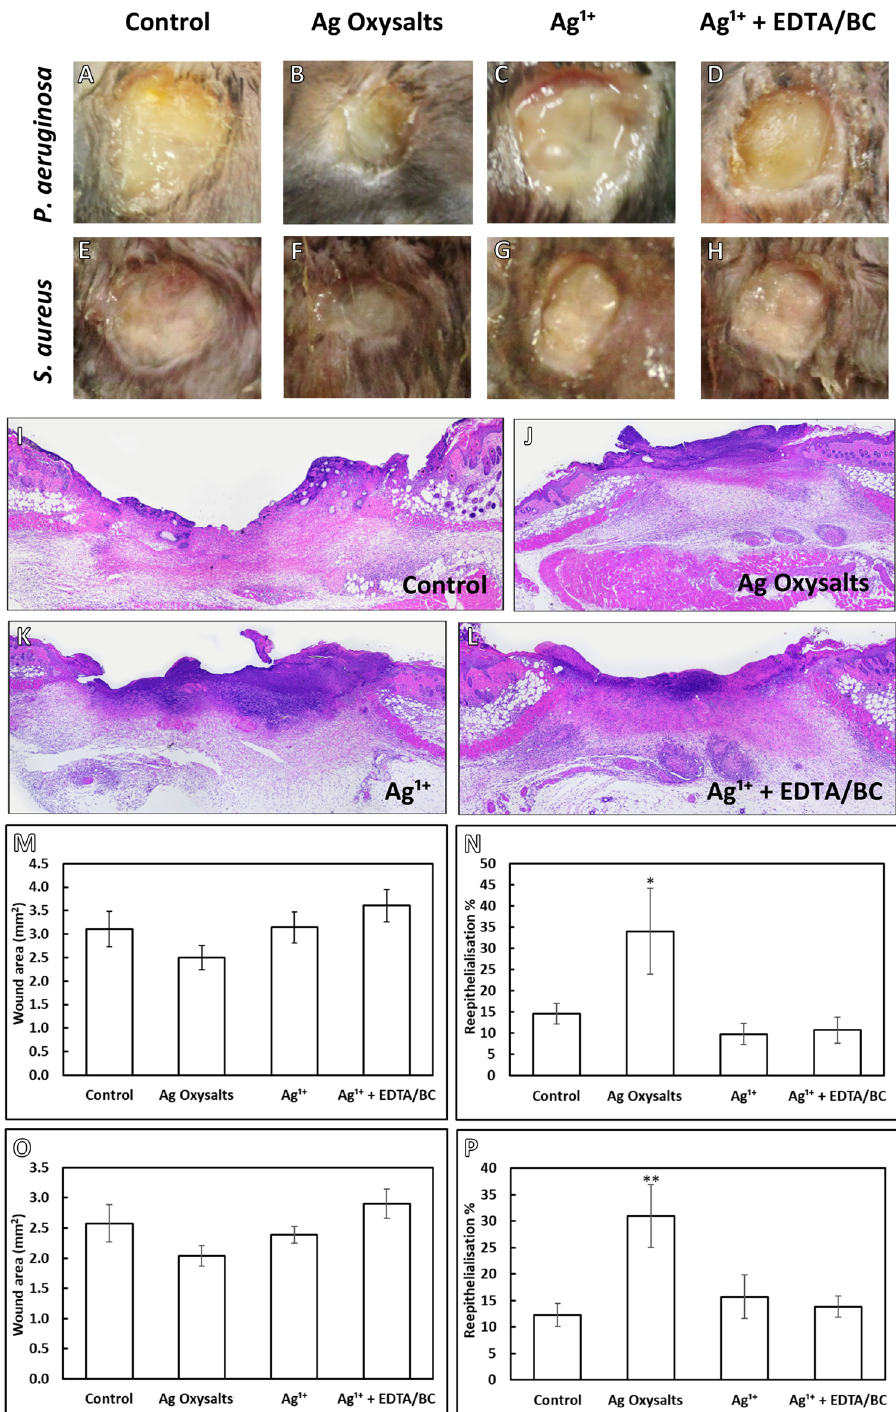
Figure 3. Effects of silver dressings on wound area and re-epithelialisation in biofilm infected wounds. ( A to H ) representative macroscopic images of murine wounds infected with P. aeruginosa ( A – D ) and S. aureus ( E – H ) biofilms following three days treatment with a non-antibacterial control dressing, Ag Oxysalts dressing, Ag 1+ dressing and Ag 1+ + EDTA/BC dressing. ( I – L ) Representative P. aeruginosa infected, haematoxylin and